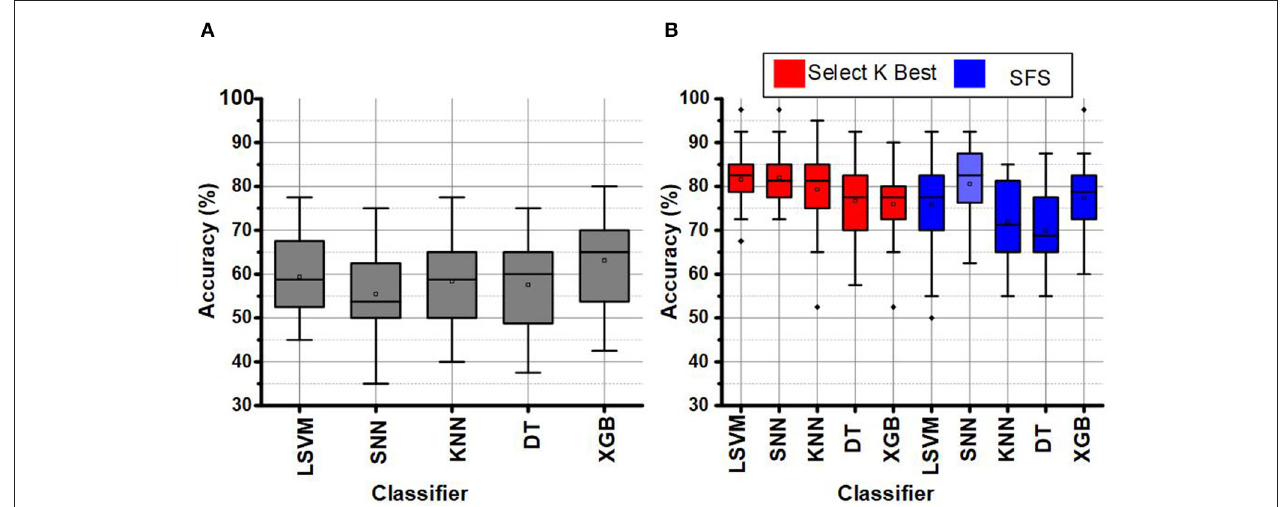
FIGURE 5 | (A) LSFE classification of EEG signals, and (B) FS using SKB and SFS for DEAP data set.